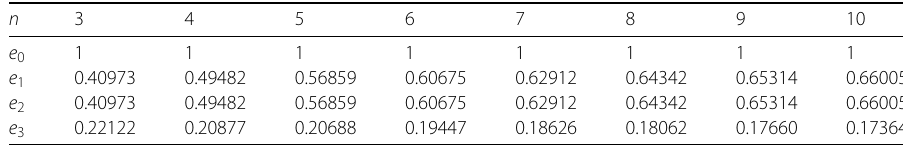
Table 1 Eigenvalues of trigonometric (i.e., μ (cid:2) +1 = cos( π /3 × 2 (cid:2) +1 )) subdivision matrix with valence n n 3